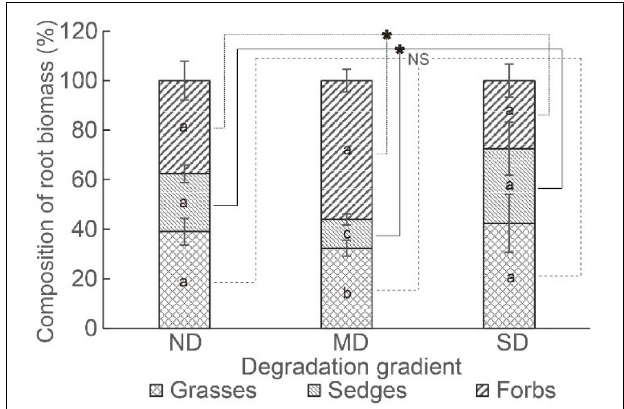
FIGURE 5 | The root competition in different degradation gradients. The “*” means a significant difference among degradation gradients. Different lowercase letters mean significant differences between functional groups in each degradation gradient.